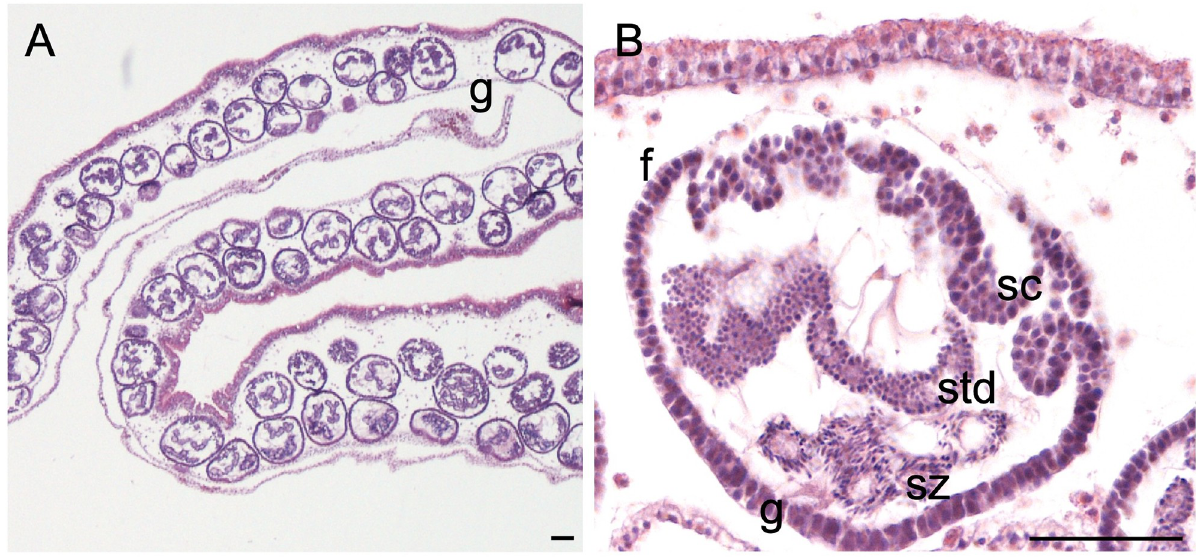
Fig 2. Histological section of a male gonad. (A) Structure of testis (B) Sperm follicle. f follicle, sc spermatocytes, std spermatids, sz spermatozoa, g gastrodermis. Sperm follicles ranged 93–115 μ m during the sampling period. Scale bar = 50 μ m.